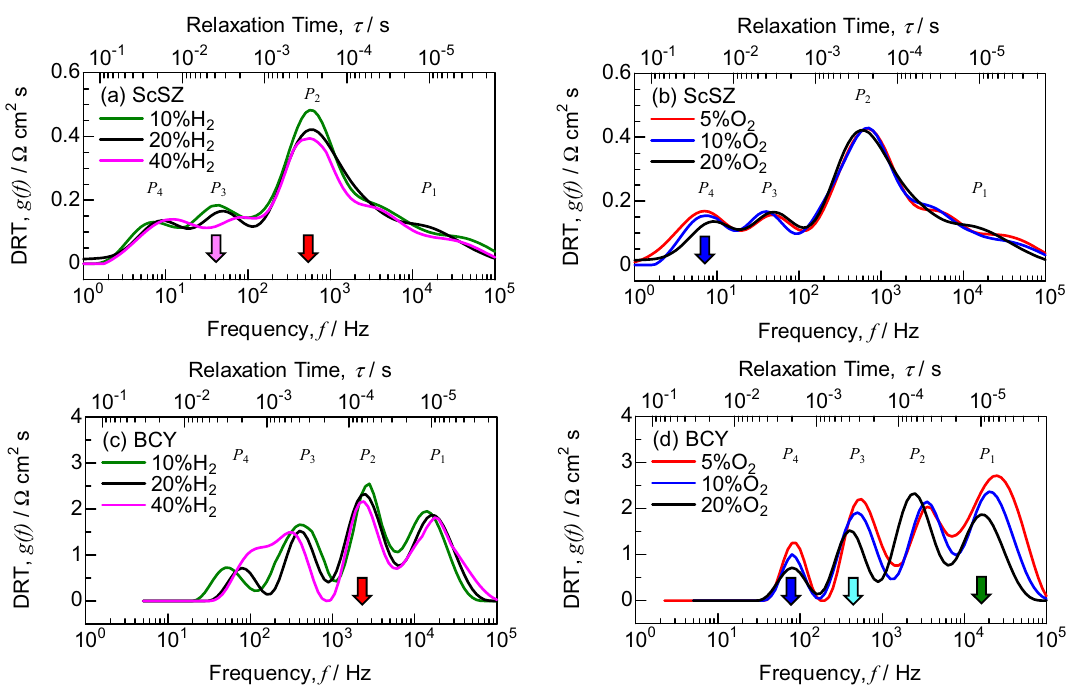
Figure 4. DRT spectra at 700 °C in ( a , c ) the constant oxidant of O 2 :H 2 O:N 2 = 20:3:77 vol.% and ( b , d ) the constant fuel of H 2 :H 2 O:N 2 = 20:3:77 vol.% for SOFCs supported on ScSZ electrolyte and PCFCs supported on BCY